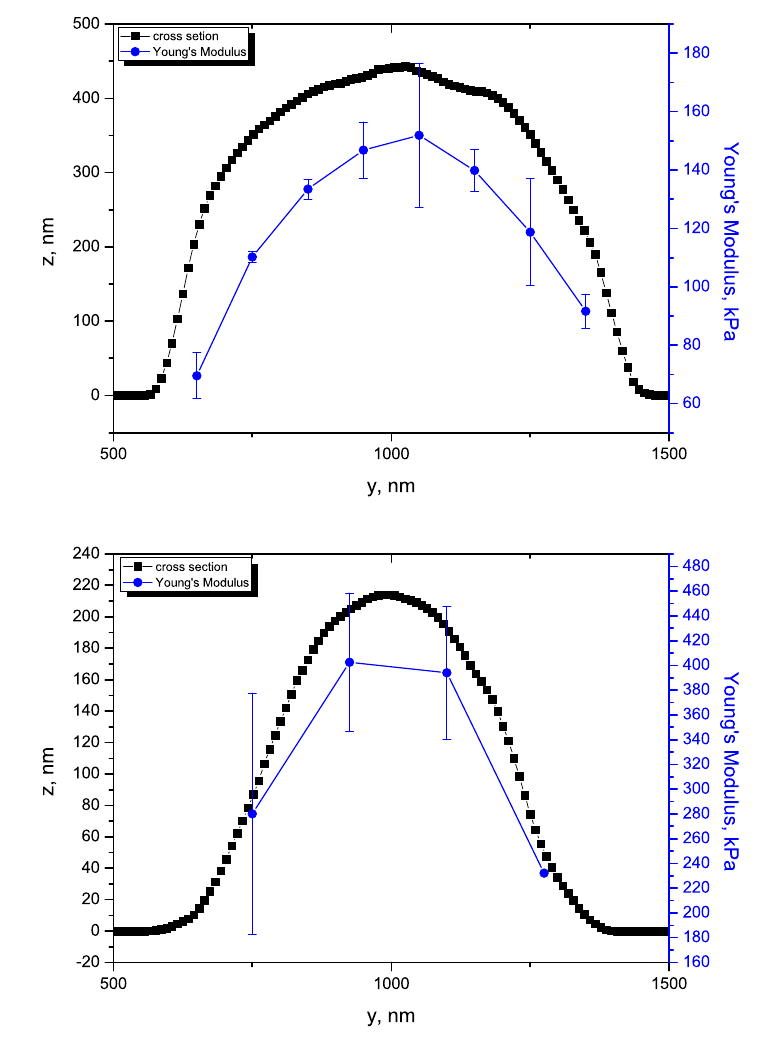
Figure 9. Height and Young’s modulus versus the cross section. Top: microgel synthesised with 20% AAc at 20 ◦ C, bottom: same particle at 70 ◦ C. It is shown that the Young’s modulus follows the cross section height and increases with